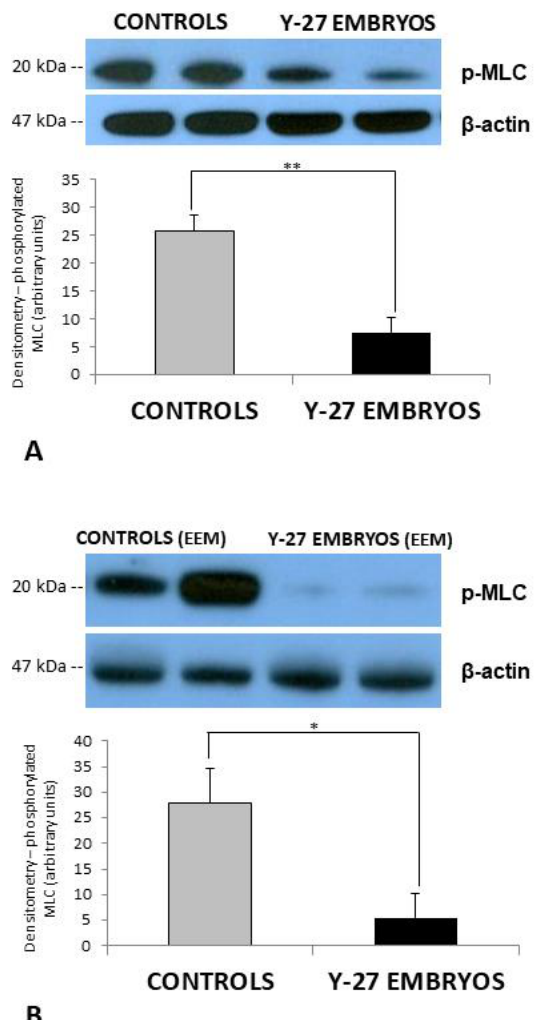
Figure 7. Embryos treated with vehicle (controls, A ) or Y-27632 (500 µM, A ) and EEM of controls ( B ) or Y-27632-treated embryos ( B ) were subjected to Western blot at 60 + 8 h to detect phosphorylated MLC. The results show that the amount of phosphorylated MLC was significantly reduced in Y-27632-treated embryos in comparison to controls ( A , ** p < 0.001 and B , * p < 0.05). The vertical bars represent the SD. y-axis: Densitometry (grey levels, arbitrary units).